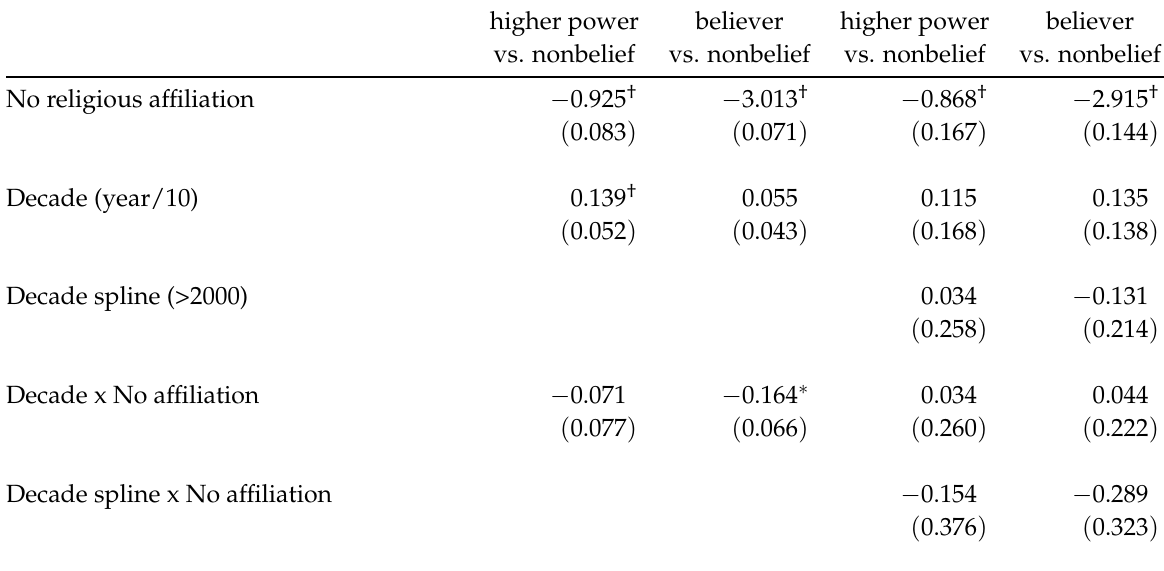
Table 3: Multinomial logit models predicting the level of belief in God based on General Social Survey